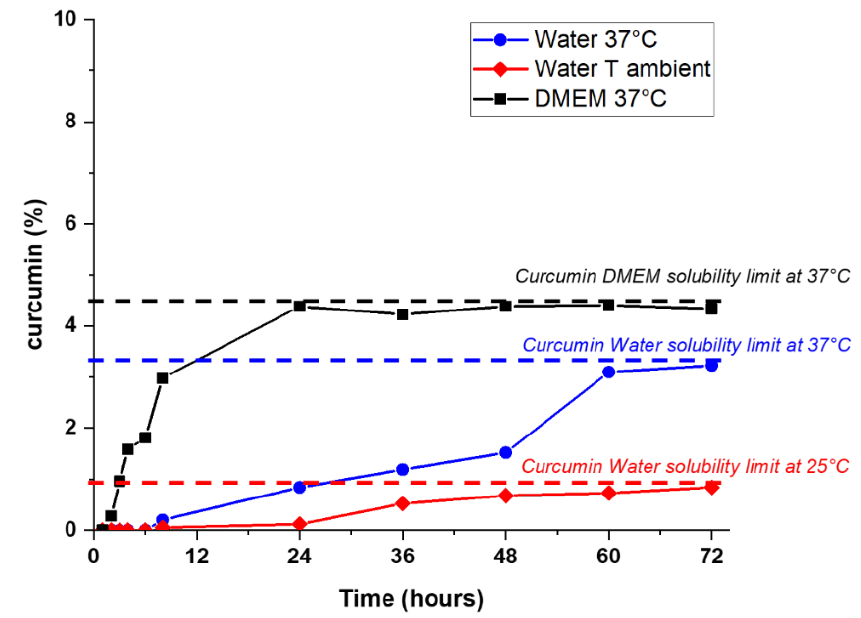
Figure 6. Release kinetics of curcumin from PGS 5.0 C 0.5 NPs in DMEM at 37 °C (blank), water at 37 °C (blue), and water at room temperature (red).